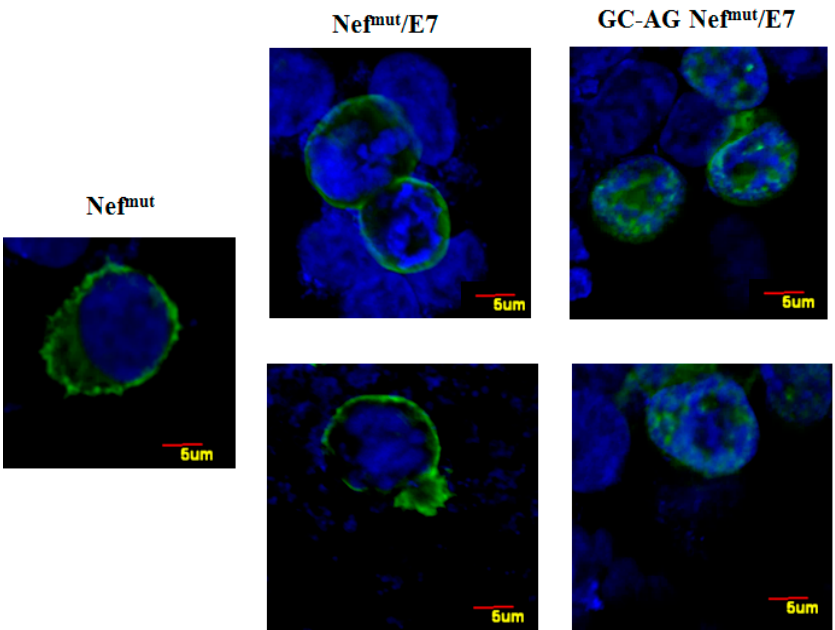
Figure 2. Intracellular localization of both Nef mut / E7 and GC-AG Nef mut / E7. Confocal microscope analysis of HEK-293T cells transfected with either Nef mut , Nef mut / E7, or GC-AG Nef mut / E7 expressing vectors. Shown are representative fields from transfected cell cultures incubated first with an anti-Nef mAb, and then with Alexa 488-conjugated anti-mouse IgGs. DAPI (blue fluorescence) was used to highlight cell nuclei. Scale bars are reported. The results are representative of two independent experiments.